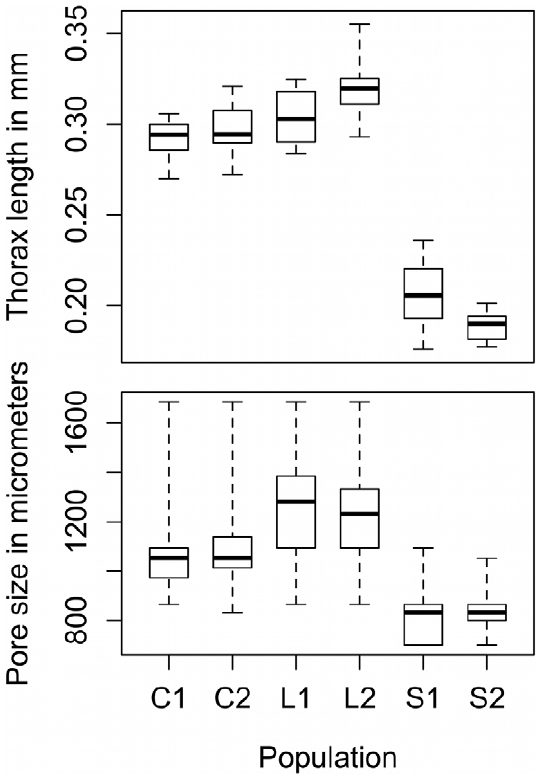
Figure 1. Response to selection. Above: Distribution of thorax length in each population after . 100 generations of selection. Below: Distribution of sieve depth in each population. Median (line), 75% quartile (box), and range (whiskers) are shown. C1, C2=controls, L1, L2=large lines, S1, S2=small lines.